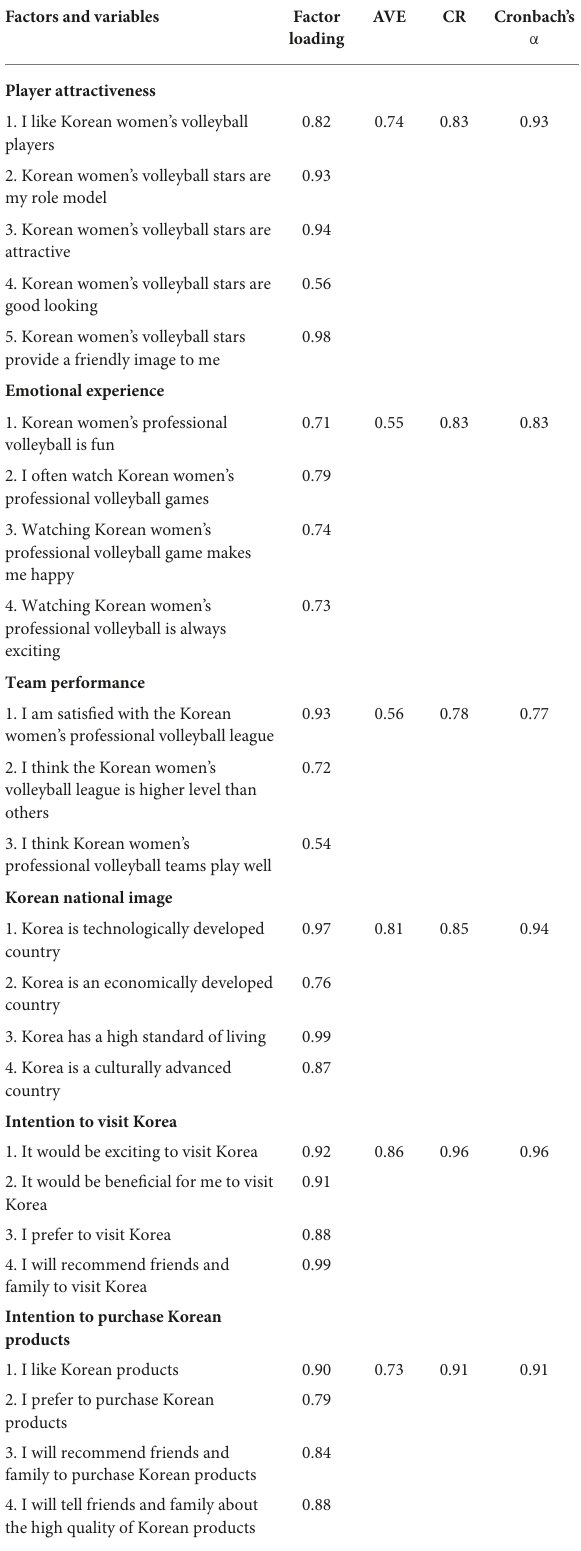
TABLE 2 Confirmatory factor analysis for validity and reliability test. TABLE 3 The squared correlations and AVE of